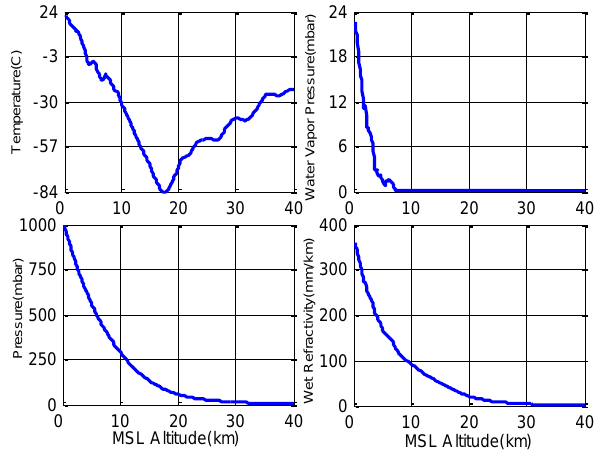
Fig. 1. Atmospheric profiles from COSMIC occultation observa- tions. X axis is Mean Sea Level (MSL) altitude.